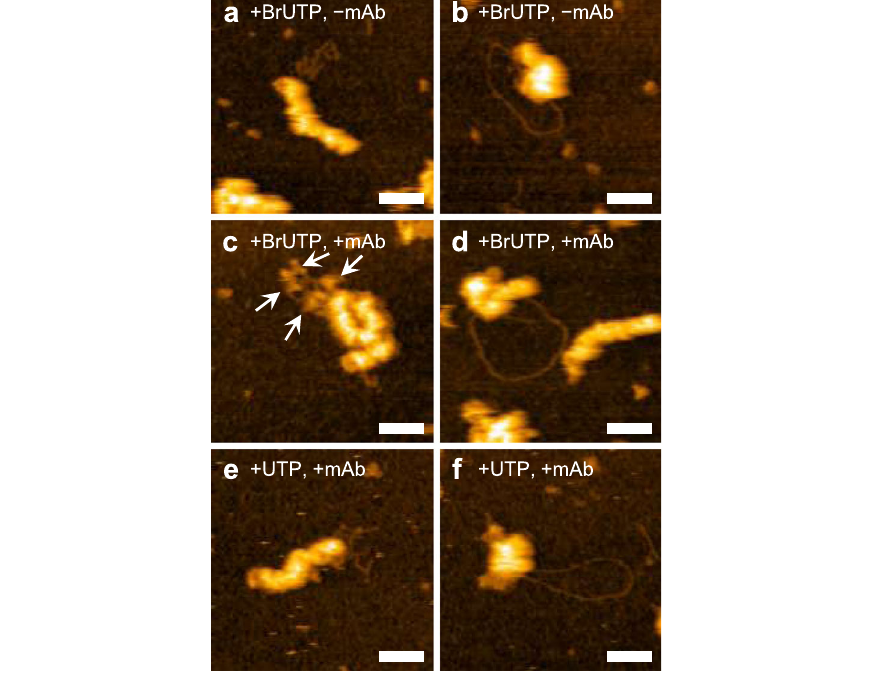
Fig. 3 Incorporation of Br-UTP into newly synthesized RNAs. a – d Br-UTP was used for in vitro RNA synthesis instead of UTP and HS-AFM images were taken without ( a, b ) or with ( c, d ) adding an antibody against Br-UTP. Binding of anti-Br-UTP antibodies was con fi rmed on folded RNAs ( c , arrows) while no binding was observed on looped RNAs ( d ). Section analysis of the image ( c ) is shown in Supplementary Fig. 5. e, f vRNPs were in vitro transcribed using UTP and anti-Br-UTP antibody was added to the mixture. Each of these results was reproduced at least three times. Scale bars, 50